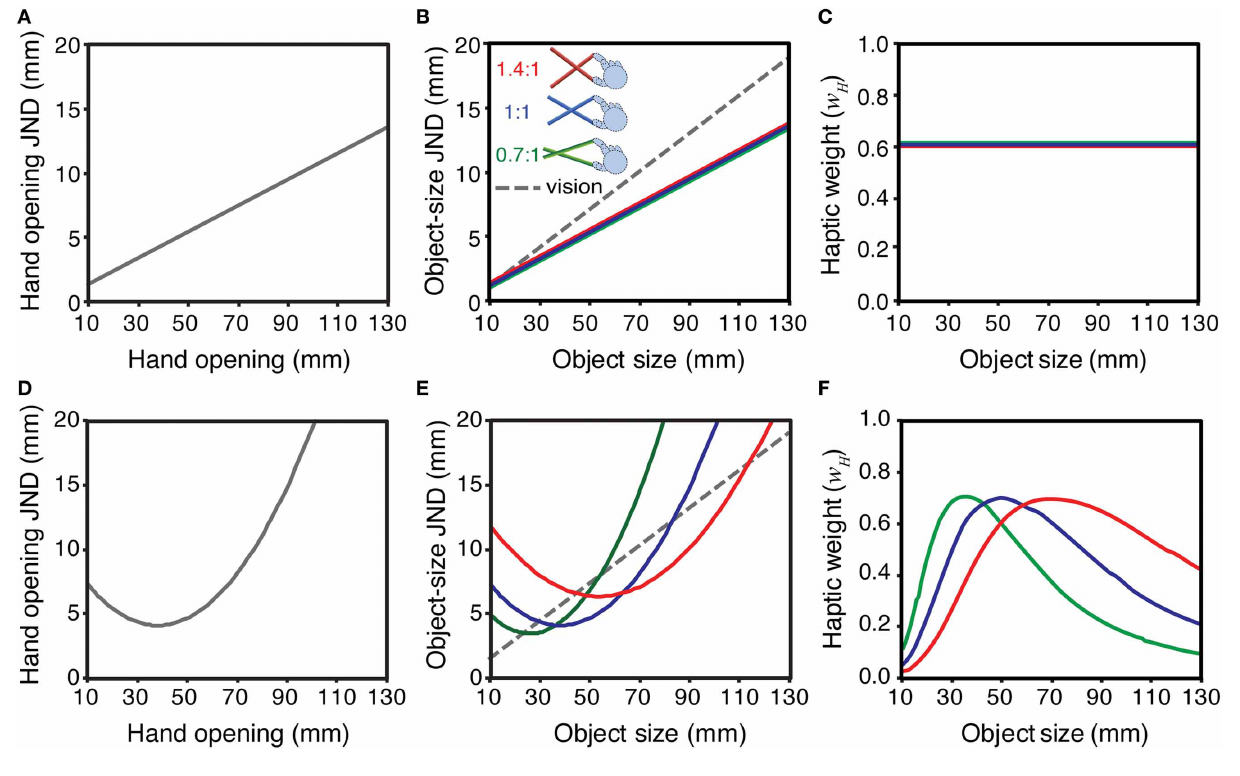
object size, with different tool gains (0.7:1, 1:1, and 1.4:1; see main text for details), and a hypothetical visual sensitivity function; (C) the optimal signal weights that result from the sensitivities in panel (B) , calculated using Equation 2. Panels (D–F) show the same calculations assuming a non-linear hand-opening sensitivity